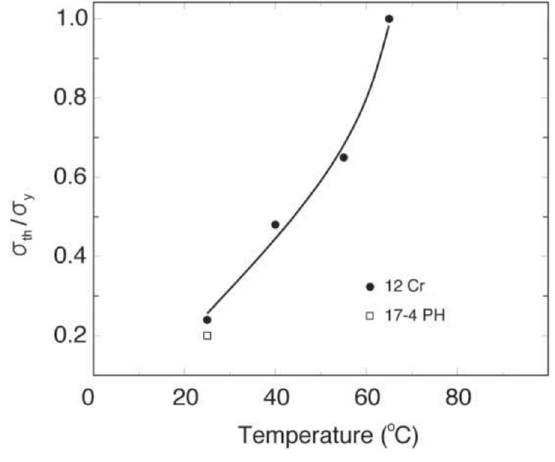
Figure 14. Permanent stress level vs. temperature as the condition favoring the SSC occurrence [11].